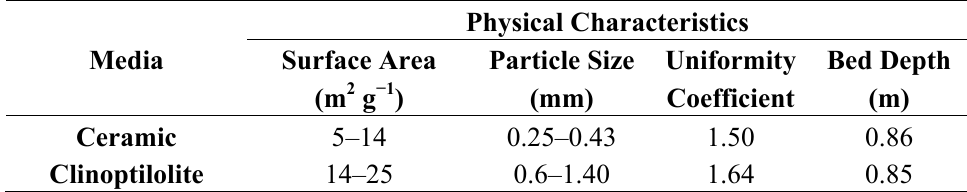
Table 5. Physical characteristics of